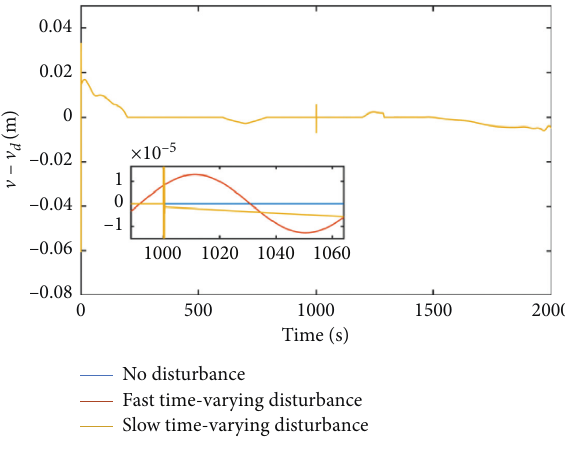
Figure 17: Velocity tracking error of the HST.